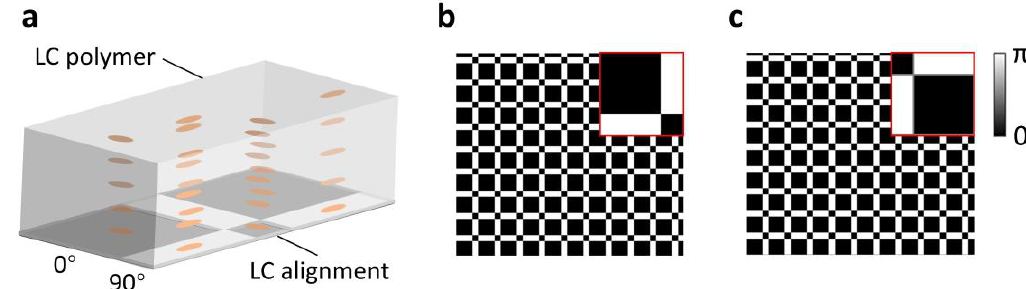
Figure 2. ( a ) Liquid crystal director distribution in a Dammann grating-patterned liquid crystal polymer film. ( b ) Phase profile of a control Dammann grating. ( c ) Phase profile of the customized Dammann grating. The insets show the phase profile within a repeating unit. Note that in ( c ), there is a single pixel line with π/2 phase between 0 and π phase domains.